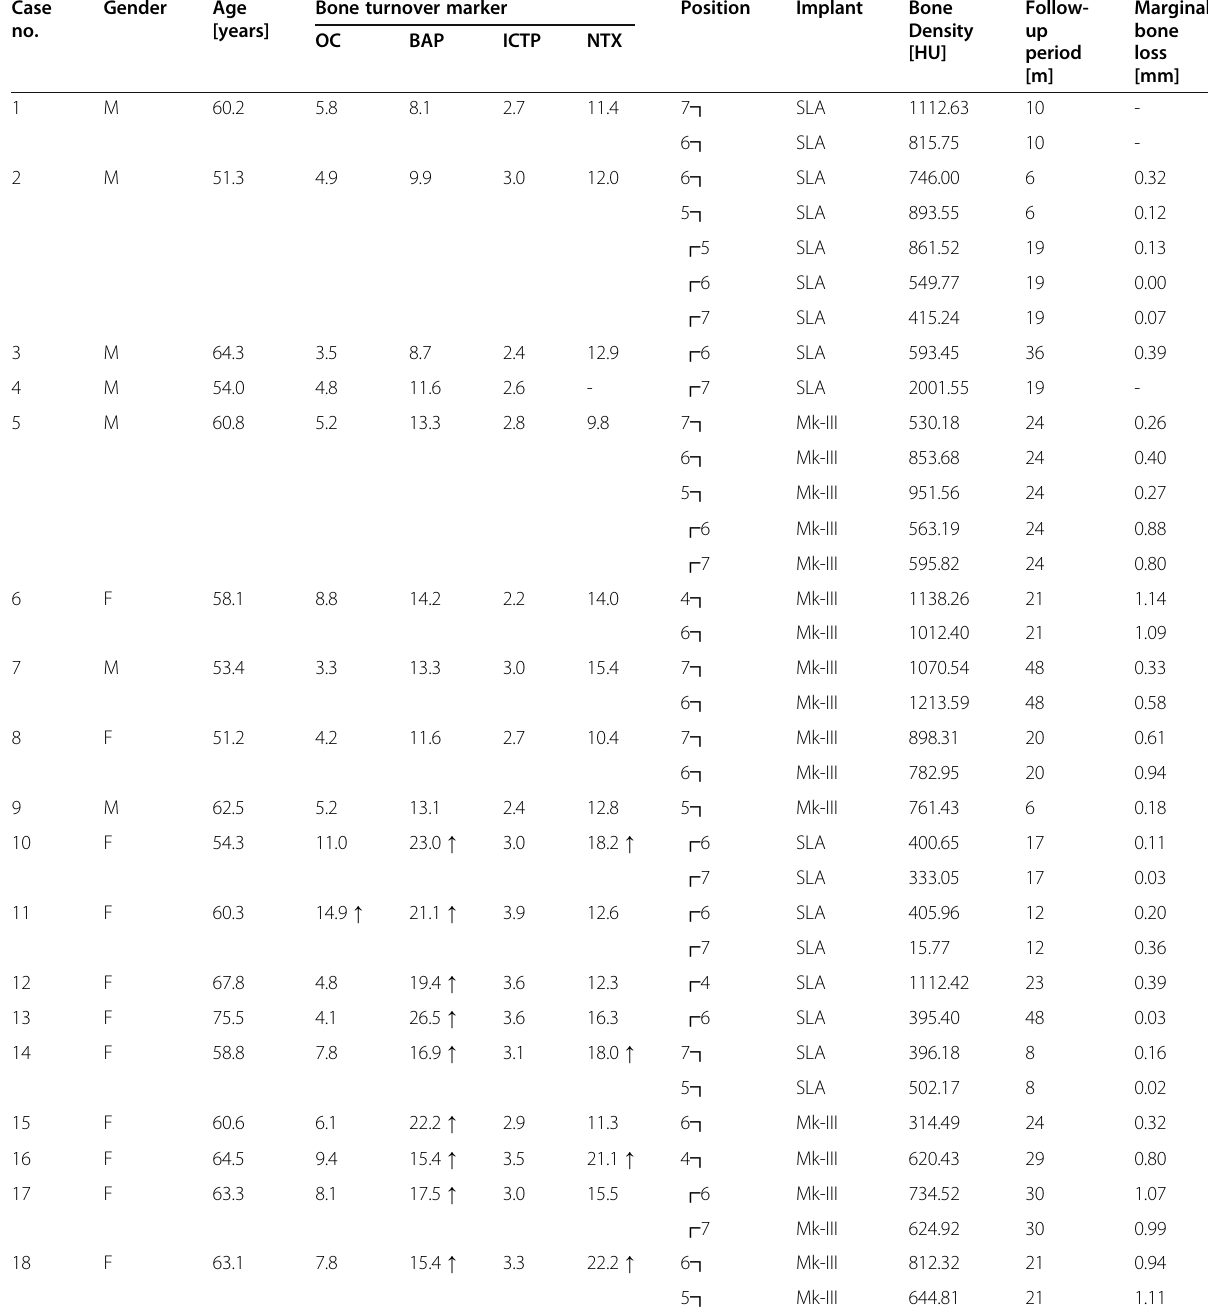
Table 1 Each parameter of the 18 patients who fulfilled the inclusion criteria Case